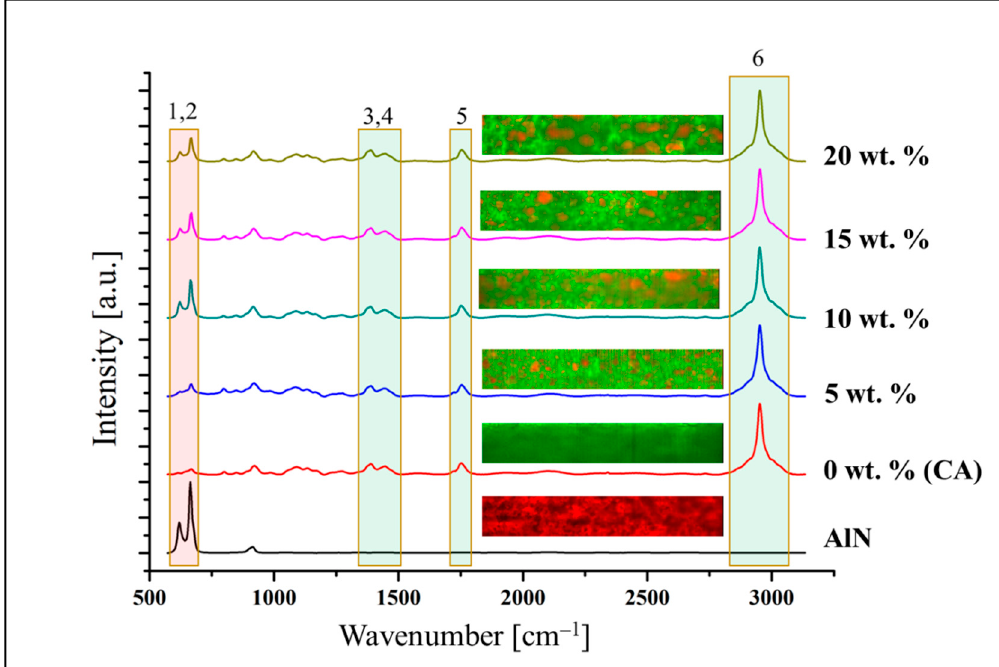
Figure 5. Raman average spectra of the CA/AlN composites.